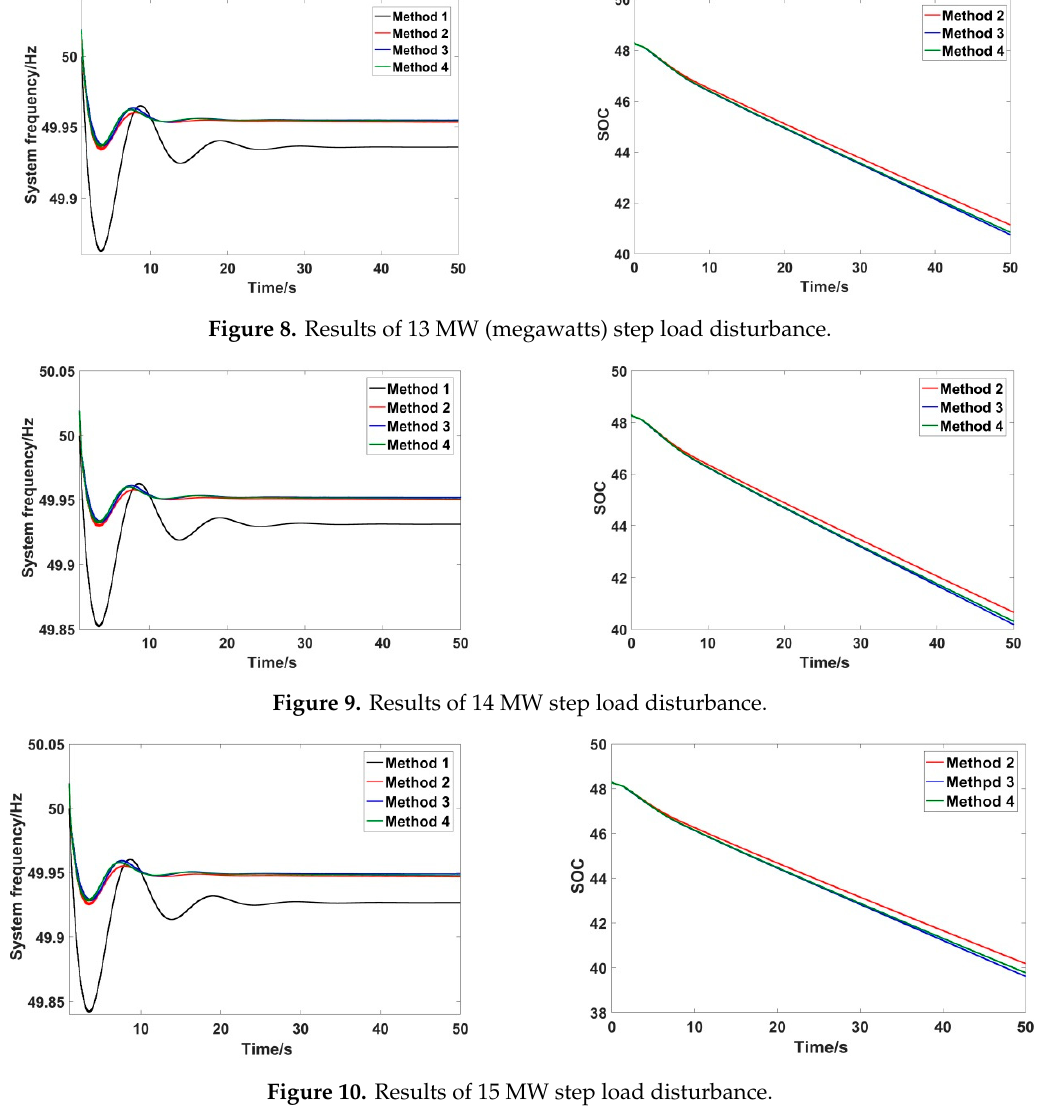
Figure 11. Results of 16 MW step load disturbance. Figure 12. Results of 17 MW step load disturbance.